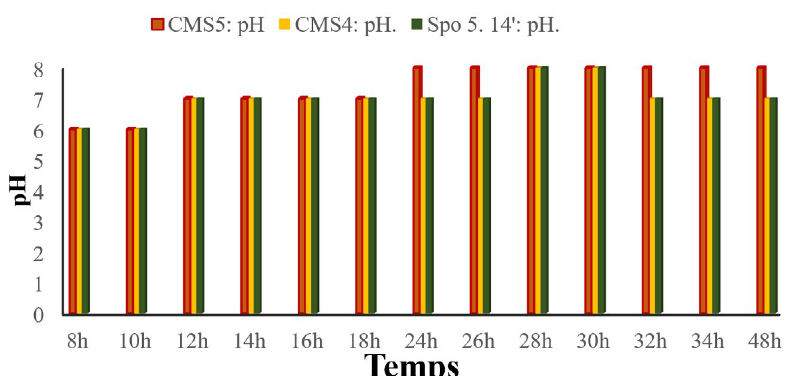
Fig. 4. Growth kinetics in Bacillus subtilis (CMS5), Bacillus sp. (CMS4) and Bacillus velenzensis (SPo5 14') as a function of time.